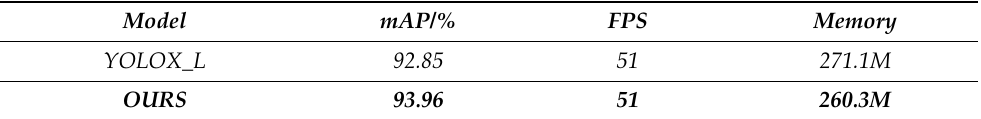
Table 5. Effectiveness of our head on YOLO_L.